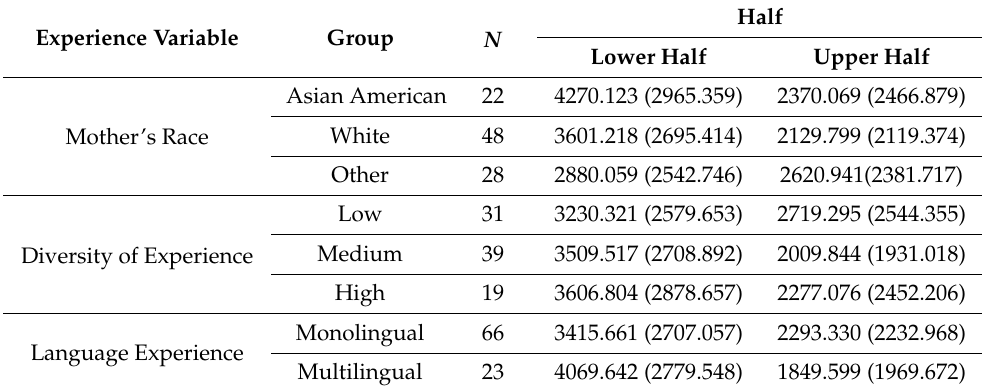
Figure 6. Looking at the upper and lower regions of the faces by ( A ) mother’s race, ( B ) diversity of experience, and ( C ) language experience, averaged across infants and trial type. The colored letters that correspond to each marginal mean point represent simple contrasts of the estimated marginal means with Tukey post-hoc corrected p -values for multiple comparisons. Marginal means with different corresponding letters (i.e., points “a” and “b” in panel c) significantly differ. Error bars represent 95% Sidak-adjusted confidence intervals. Table 3. Observed mean (SD) looking time for the upper and lower halves of the faces for each experience group, as reflected in the 2-way interactions between experience and AOI in Figure